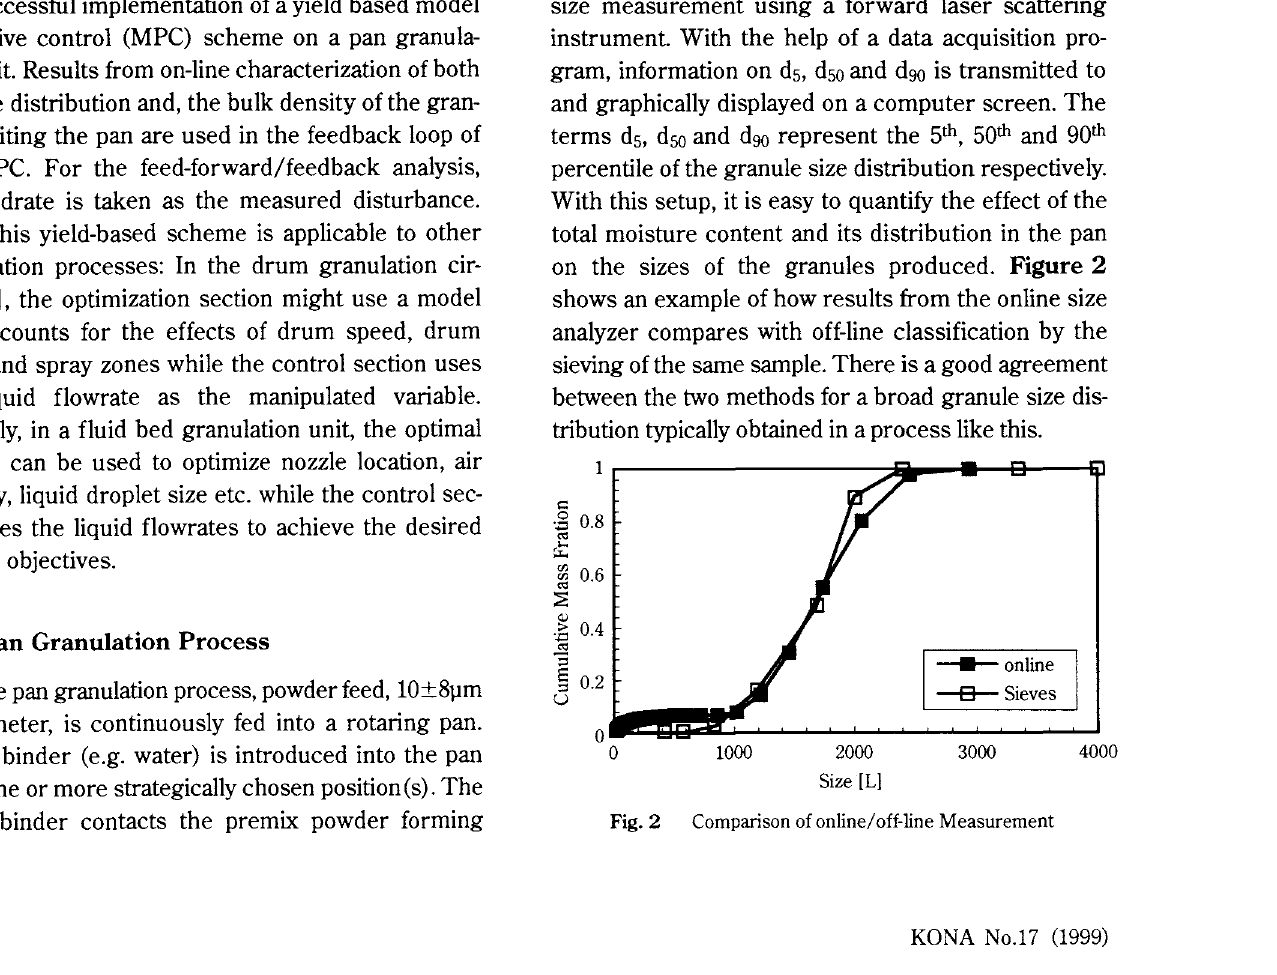
Comparison of online/off·line